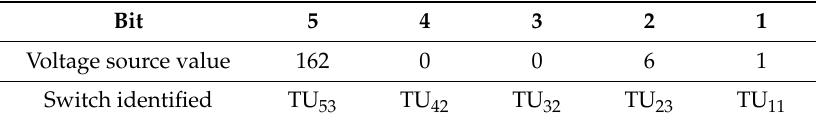
Table 4. Selection of voltage sources and